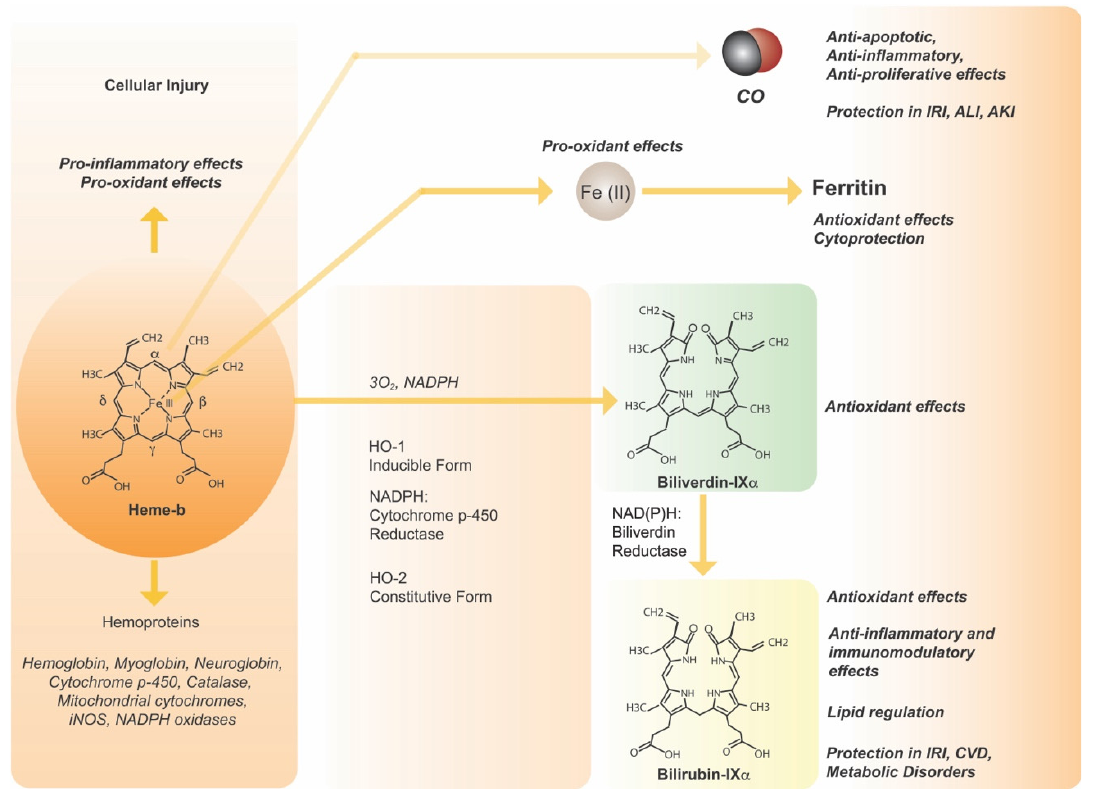
Figure 1. Enzymatic heme catabolism. Heme is a vital molecule used as a prosthetic group for diverse cellular heme-containing proteins, including oxygen carriers (i.e., hemoglobin, myoglobin), mitochondrial cytochromes, and enzymes. In free form, heme can catalyze pro-oxidant reactions and promote inflammation. Heme oxygenase (HO, E.C. 1:14:14:18) catalyzes the oxidative degradation of heme to biliverdin-IX α (BV). This reaction requires 3 mol O 2 and NADPH: cytochrome p-450 reductase as the electron source. During heme cleavage, the α -methene bridge carbon of heme is released as carbon monoxide (CO), while the central heme iron is liberated as ferrous iron (Fe-II). HO activity is represented by an inducible form (HO-1) and a constitutively expressed form (HO-2). BV is converted to bilirubin-IX α (BR) by NAD(P)H: biliverdin reductase. Both BV and BR have potent cellular antioxidant activities. Additionally, BR has immunomodulatory effects, and a newly recognized role as a regulator of lipid metabolism. Iron released from HO activity may act as a pro-oxidant or trigger the synthesis of ferritin, which can act as a co-cytoprotectant by sequestering heme-derived iron. HO-1-derived CO can regulate cellular processes including inflammation, apoptosis, and cell proliferation. CO and BV/BR can confer protection in experimental models of ALI, AKI, CVD and related metabolic disorders, and organ IRI. Ferritin has also been implicated in vascular protection.